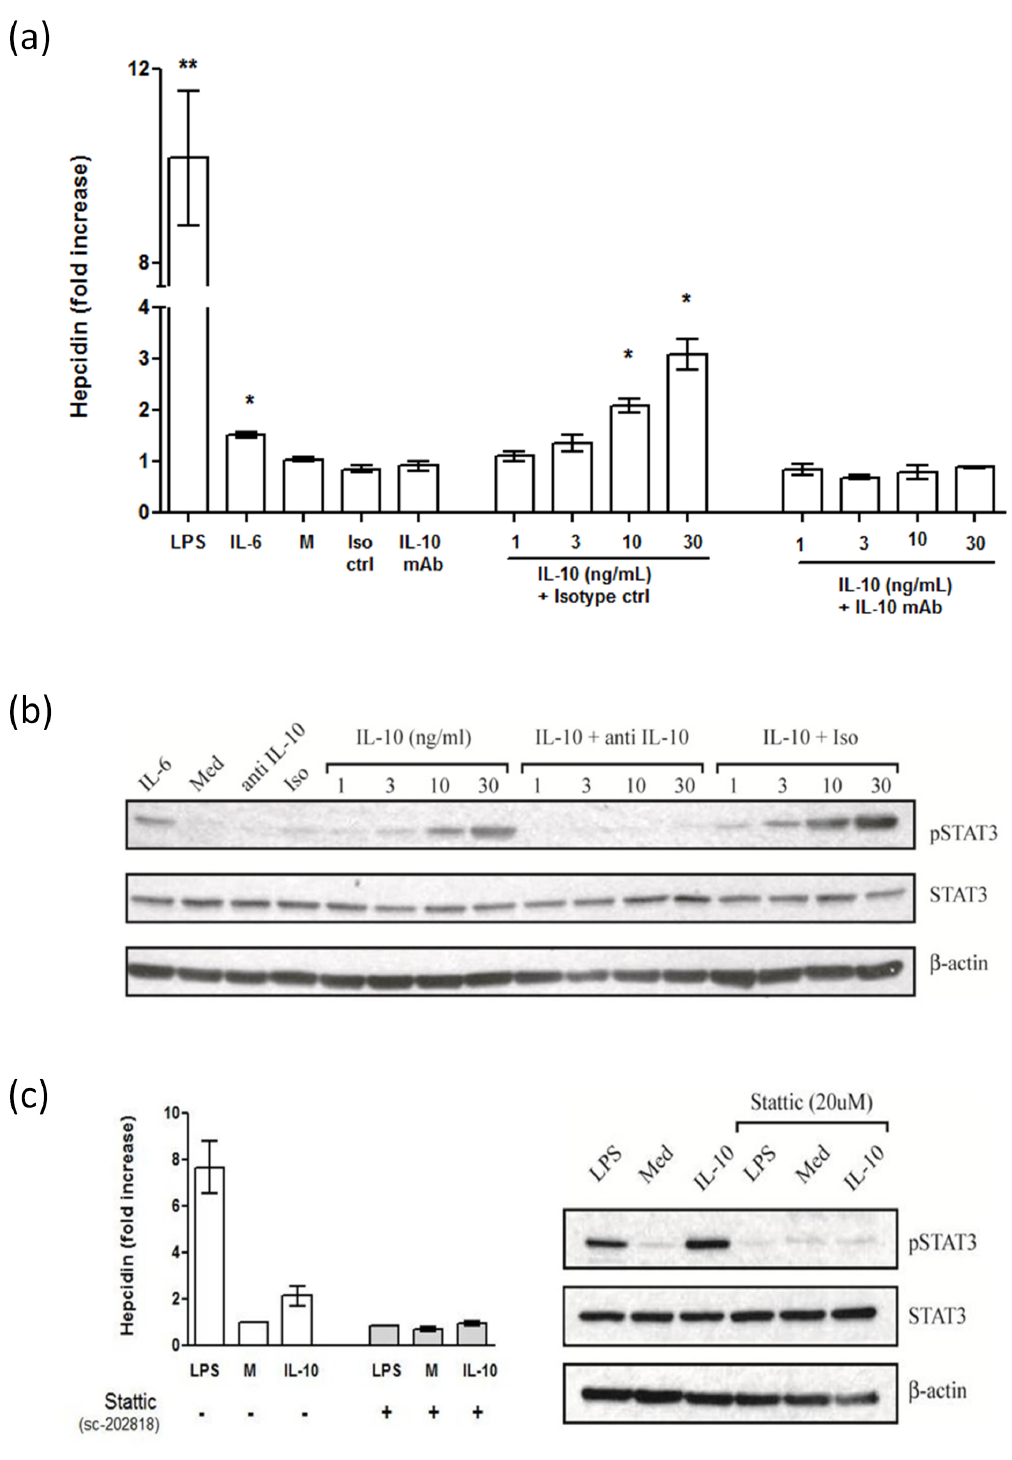
Figure 3. Regulation of hepcidin by IL-10 in primary macrophages, showing (a) the effect of IL-10 on Hepcidin mRNA synthesis with and without anti-IL-10 blocking antibody; (b) Western blot of STAT3 phosphorylation 20 minutes after exposure to increasing concentrations of IL-10; (c) STAT3-P inhibition of IL-10 (30 ng/mL) by Stattic. Bar plots show data from at least 3 independent experiments and the sho Western blot shows data from a representative experiment. M = media, iso ctrl = isotype control. * P , 0.05, *** P , 0.01 (Mann-Whitney test, compared with Media control).